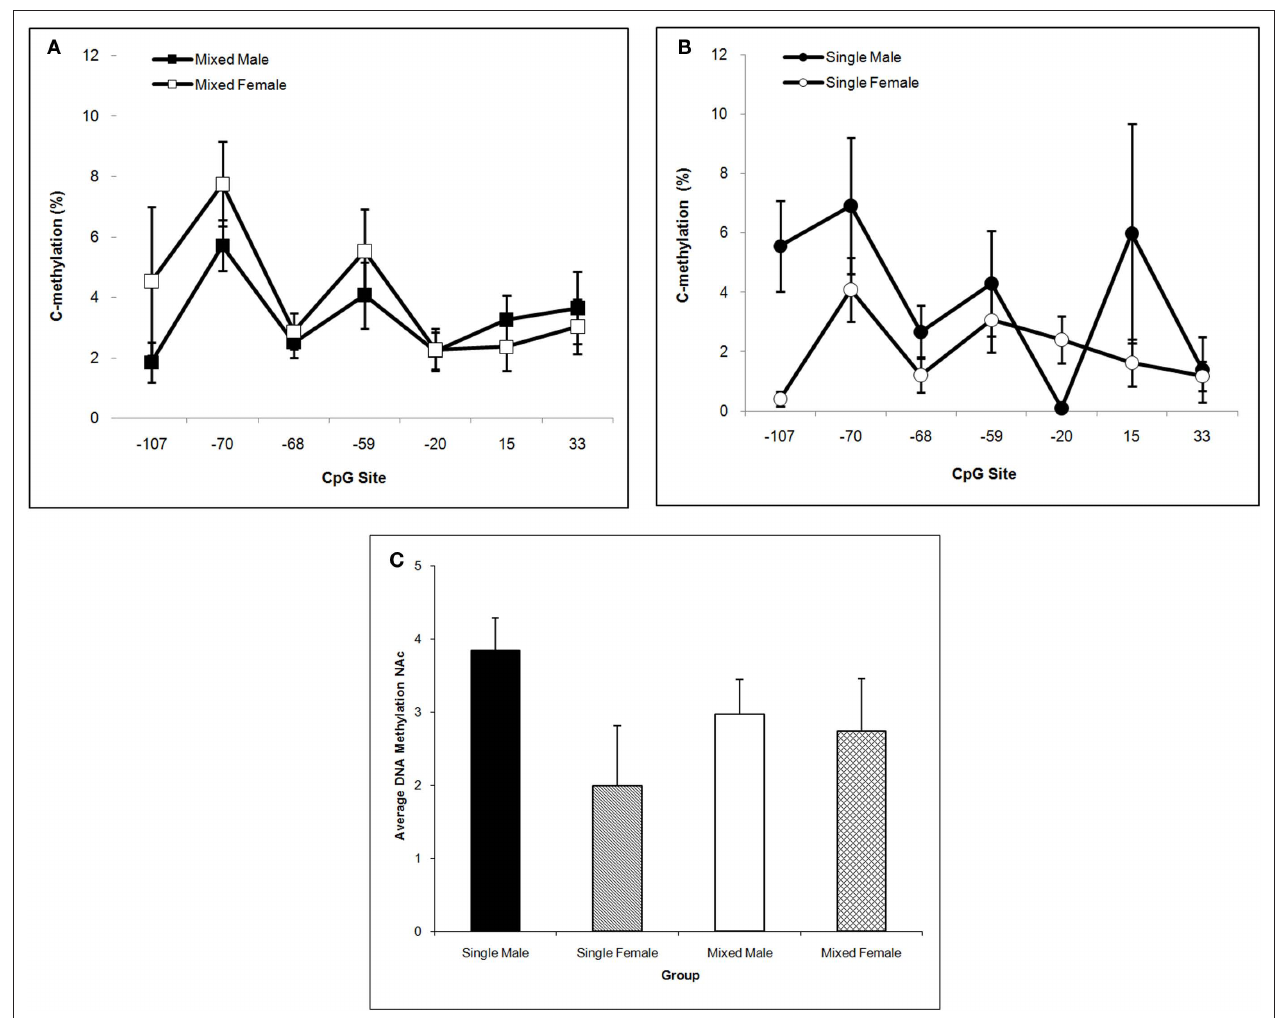
FiguRE 6 | Mean ( ± SEM) DNA methylation levels of the Oprm1 gene promoter region in nucleus accumbens are presented for mixed- [squares; (A)] and single- [circles; (B)] sex litters for male (closed symbols) and female (open